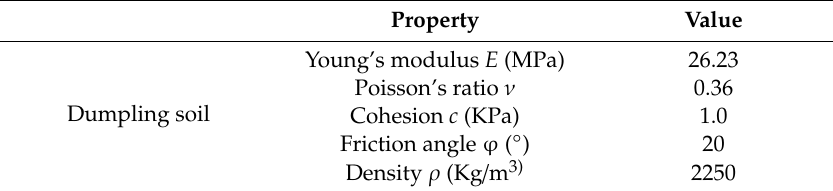
Table 2. Calculation parameters for the landslide